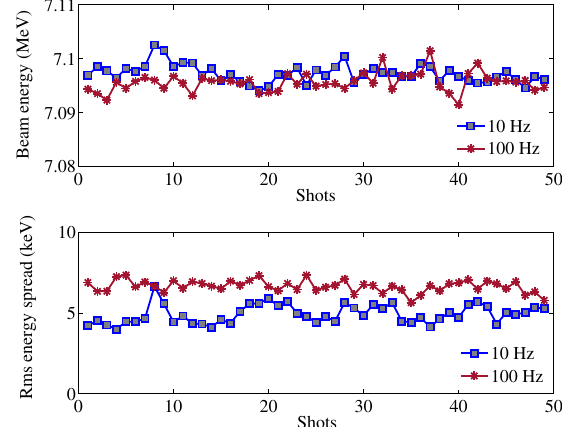
FIG. 17. Bunch mean energy jitter (top) and bunch rms energy spread (bottom) at the gun exit determined from 49 noncon- secutive shots over 30 s with a laser pulse repetition rate of 10 Hz for rf running at 10 Hz (blue squares) and 100 Hz (red